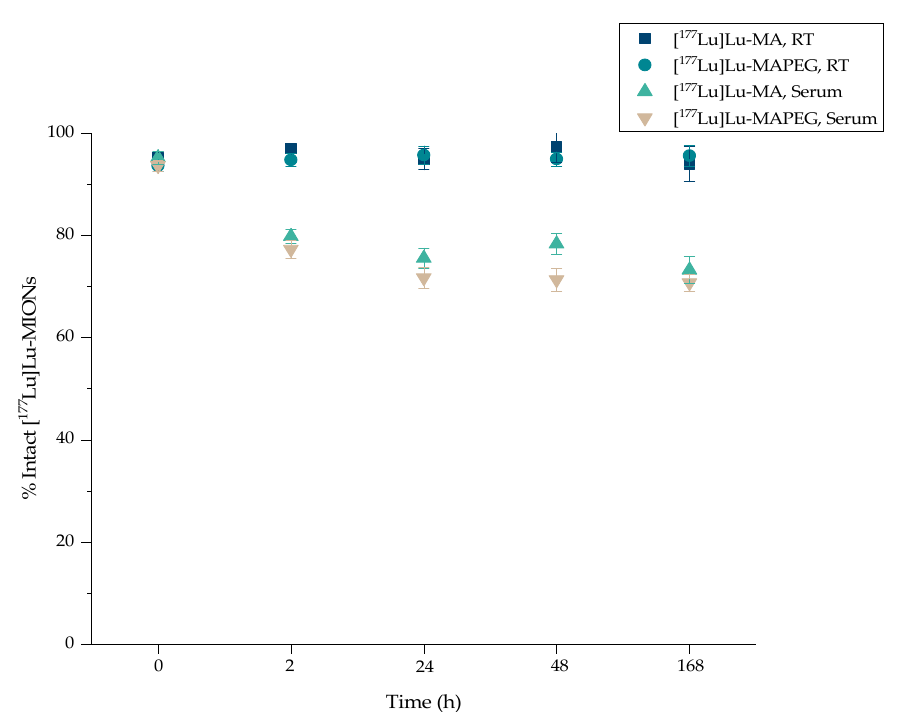
Figure 7. Radiochemical stability of [ 177 Lu]Lu-MA and [ 177 Lu]Lu-MAPEG at RT and in human serum (x axis not in scale).